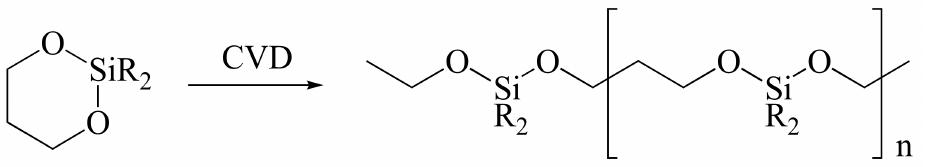
Figure 4. Ring-opening and expansion of